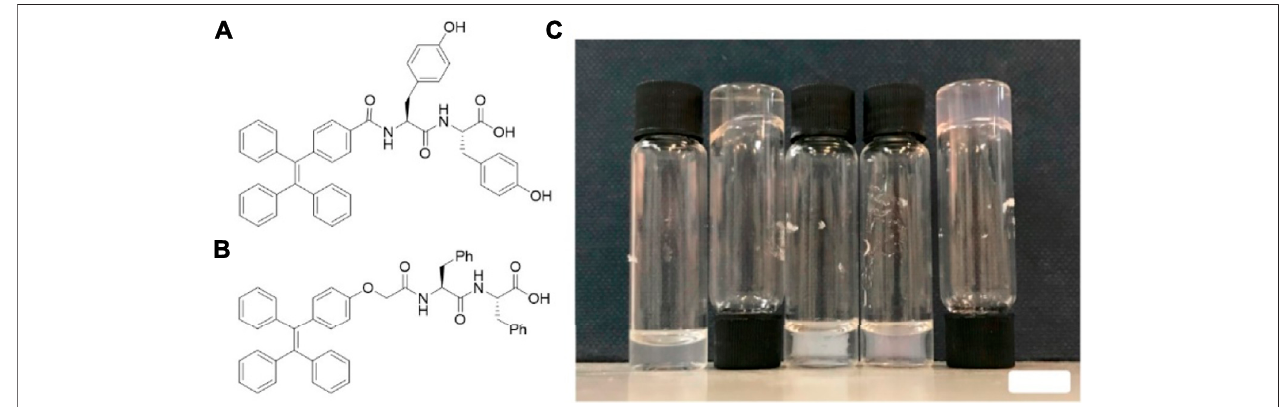
FIGURE6| Thestructureof (A) TPE-Tyr-TyrreportedbyLingroup(Yehetal.,2016); (B) TPE-Phe-Phe(TPE-FF)reportedbyAdams(Castillaetal.,2018); (C) from lefttoright,asolutionofTPE-FFat 5 mg/ml athighpH,at10 mg/mlafter aheat-coolcycle(formedhydrogel),at 5 mg/mlafter theadditionofglucono-dlactone (GdL),at 5 mg/ml after the addition of CaCl 2 , and at 5 mg/ml after the addition of NaCl (18 mg/ml) (formed hydrogel) (Castilla et al., 2018).